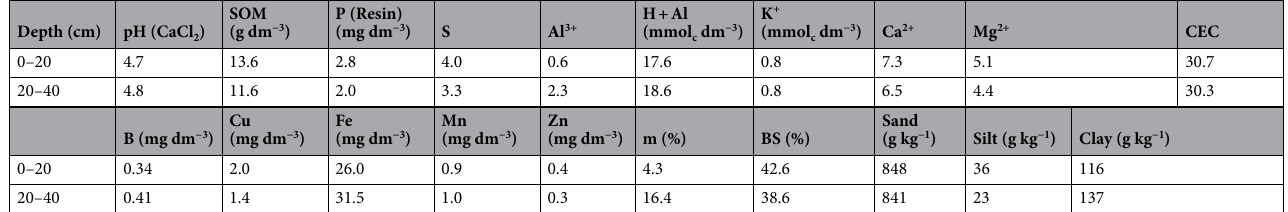
Table 3. Selected chemical properties and particle size distribution of the